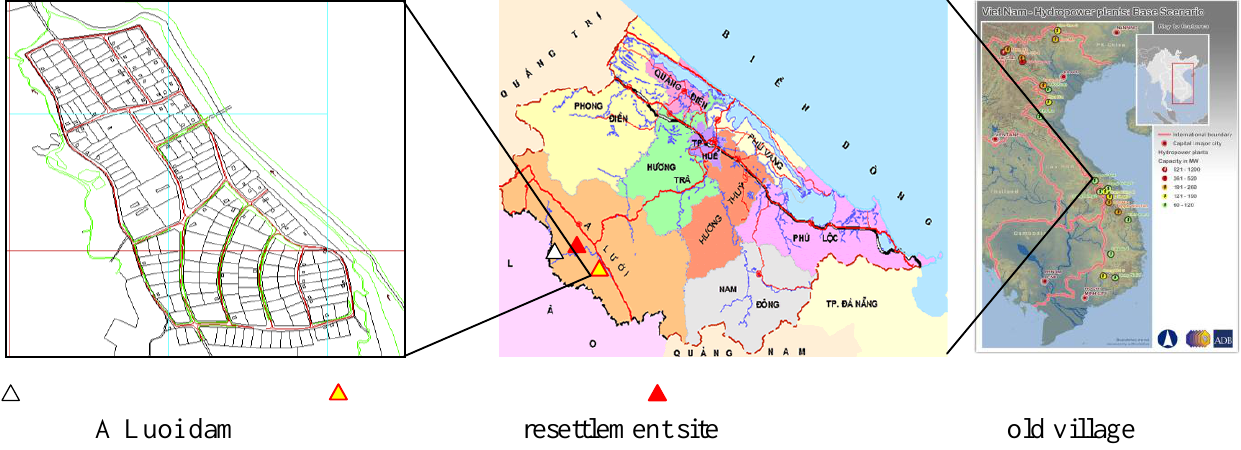
A Luoi dam resettlement site old